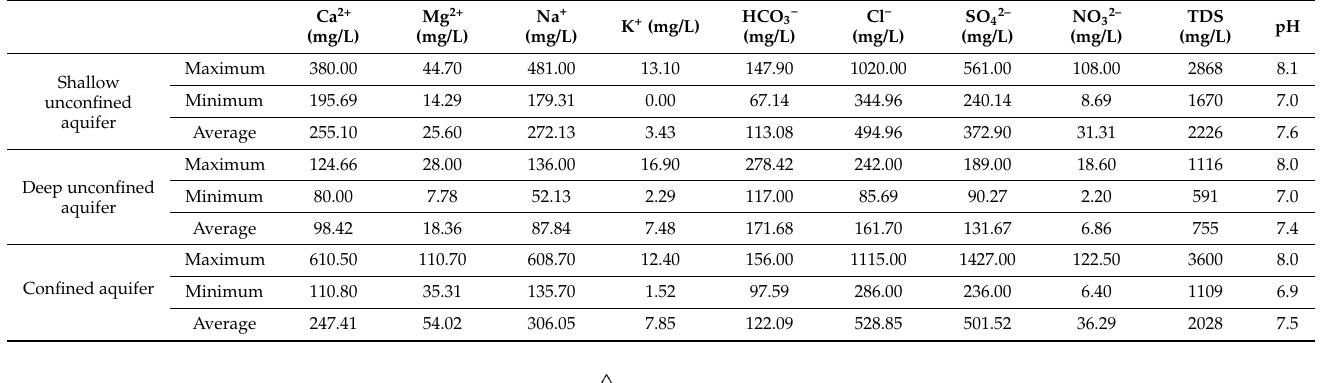
Table 1. Descriptive statistics of the tested groundwater samples from the Wajid aquifer.